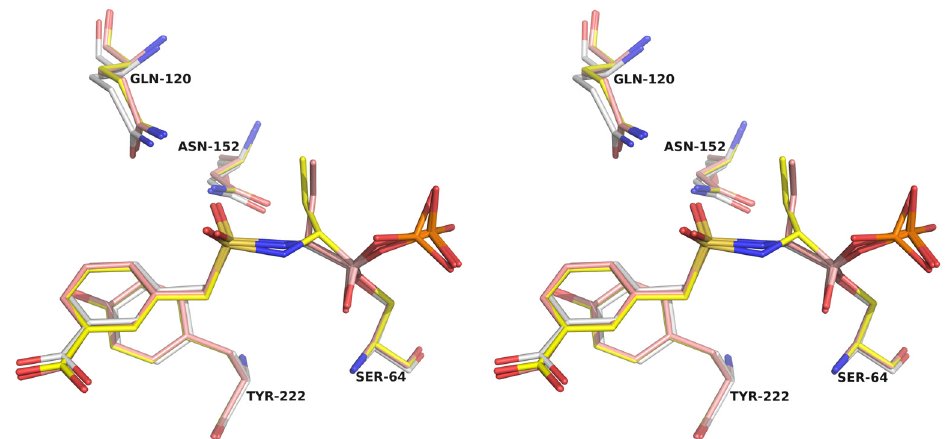
Figure 6. Stereoview superposition of ADC ‐ 33 complexes with 6d (yellow) and 6e (pink) and the ADC ‐ 7/ CR167 complex (white; 5WAE). A similar binding mode can be observed in all three